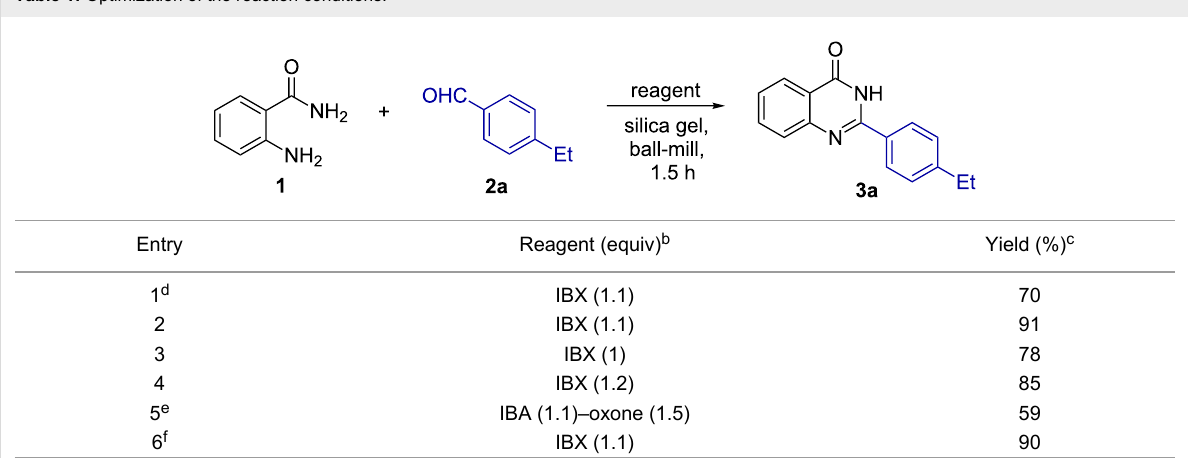
Table 1: Optimization of the reaction conditions.